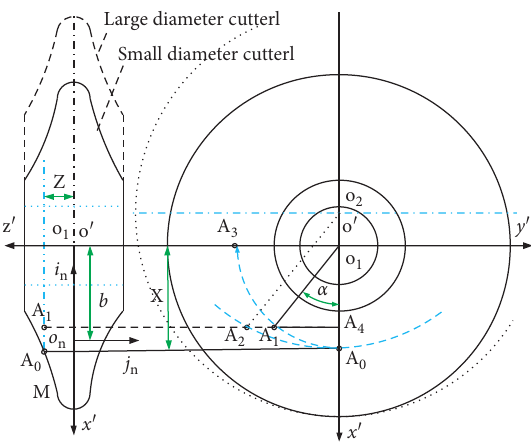
Figure 5: Analysis diagram of disc milling cutter rotation.